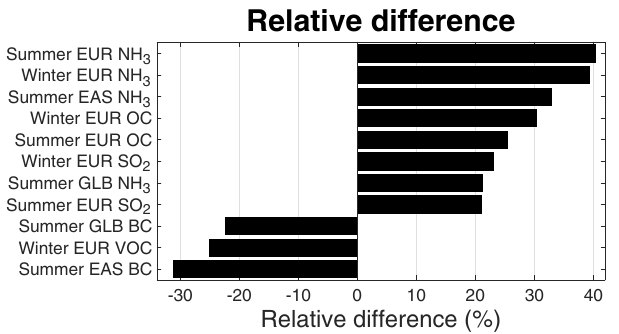
Figure 4. The relative difference between the global temperature responses based on ARTP and AGTP methods for a time horizon of 20 years. Only cases with larger relative differences than 20% are shown. Positive numbers occur when the magnitude of the global temperature response is larger when based on ARTP than on AGTP, negative when the magnitude is largest based on